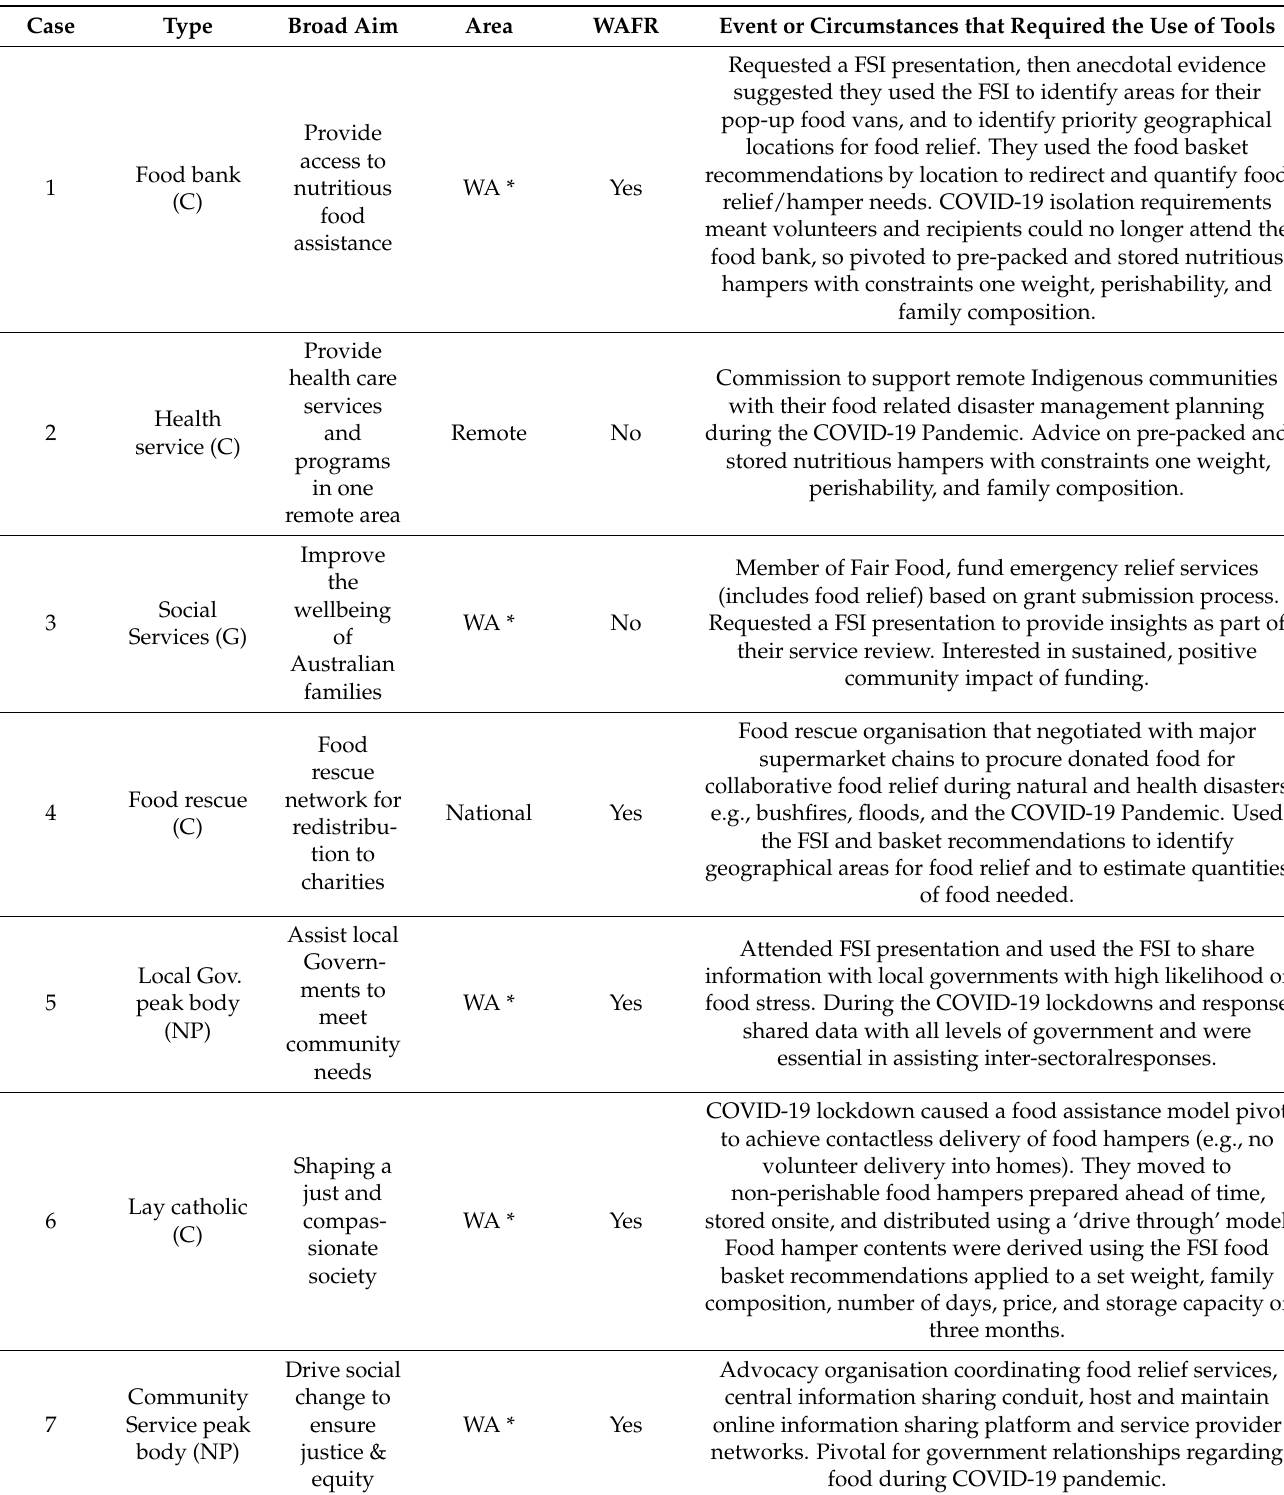
Table 1. Brief case study organisational description, context and